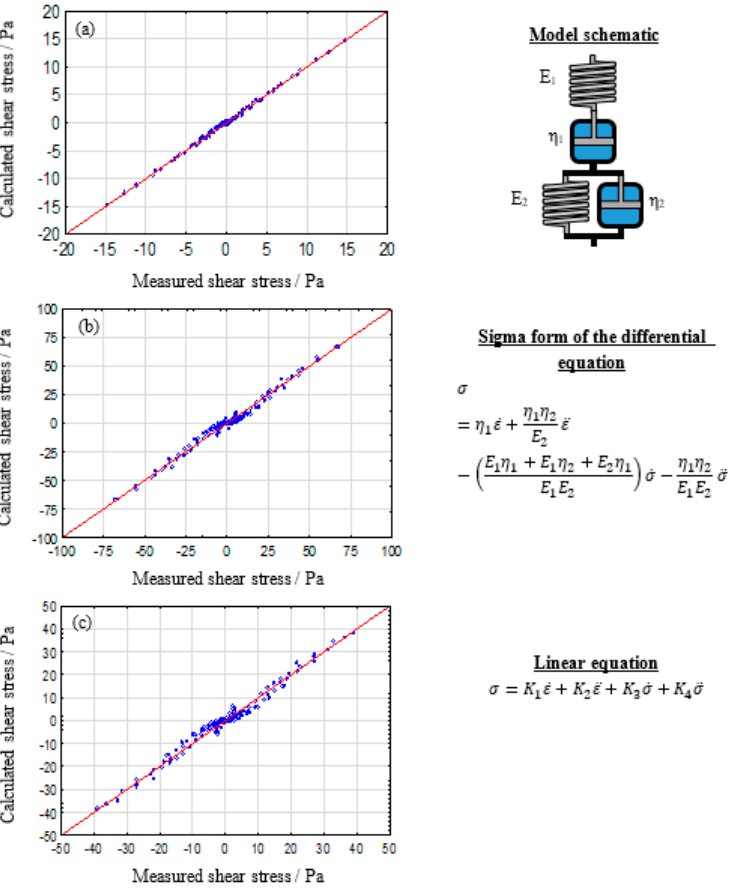
Figure 5. Calculated against measured shear stress plot for the used burgers model system for 2% ( a ), 5% ( b ), and 8% ( c ) alginate